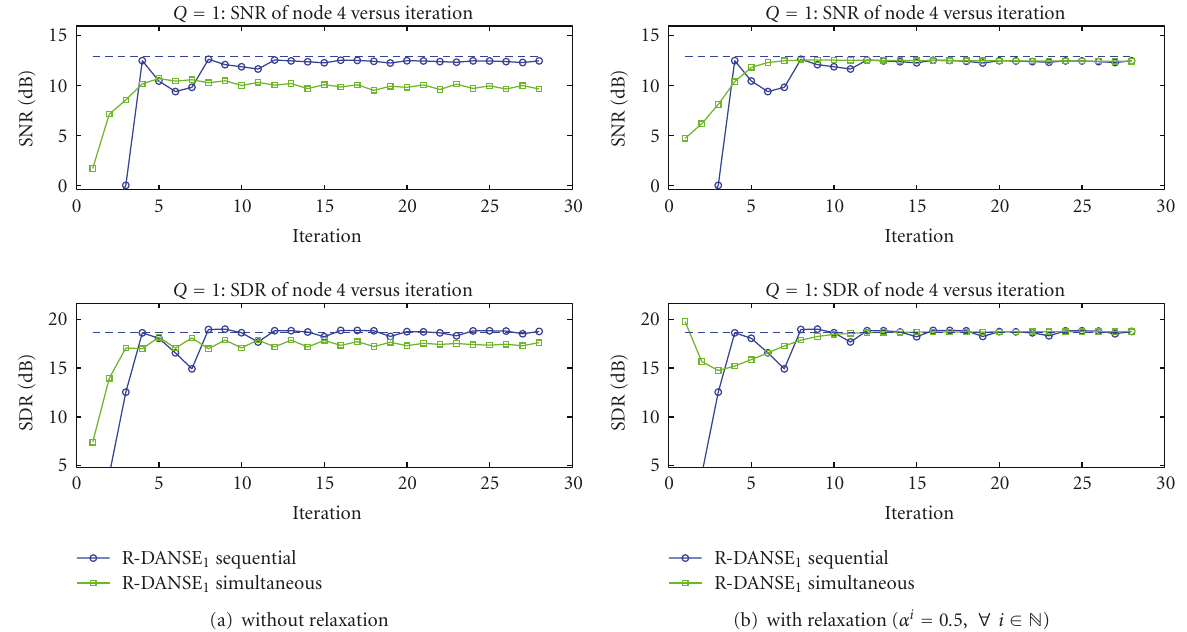
Figure 8: SNR and SDR for R-DANSE 1 versus iterations at node 4 with sequential and simultaneous